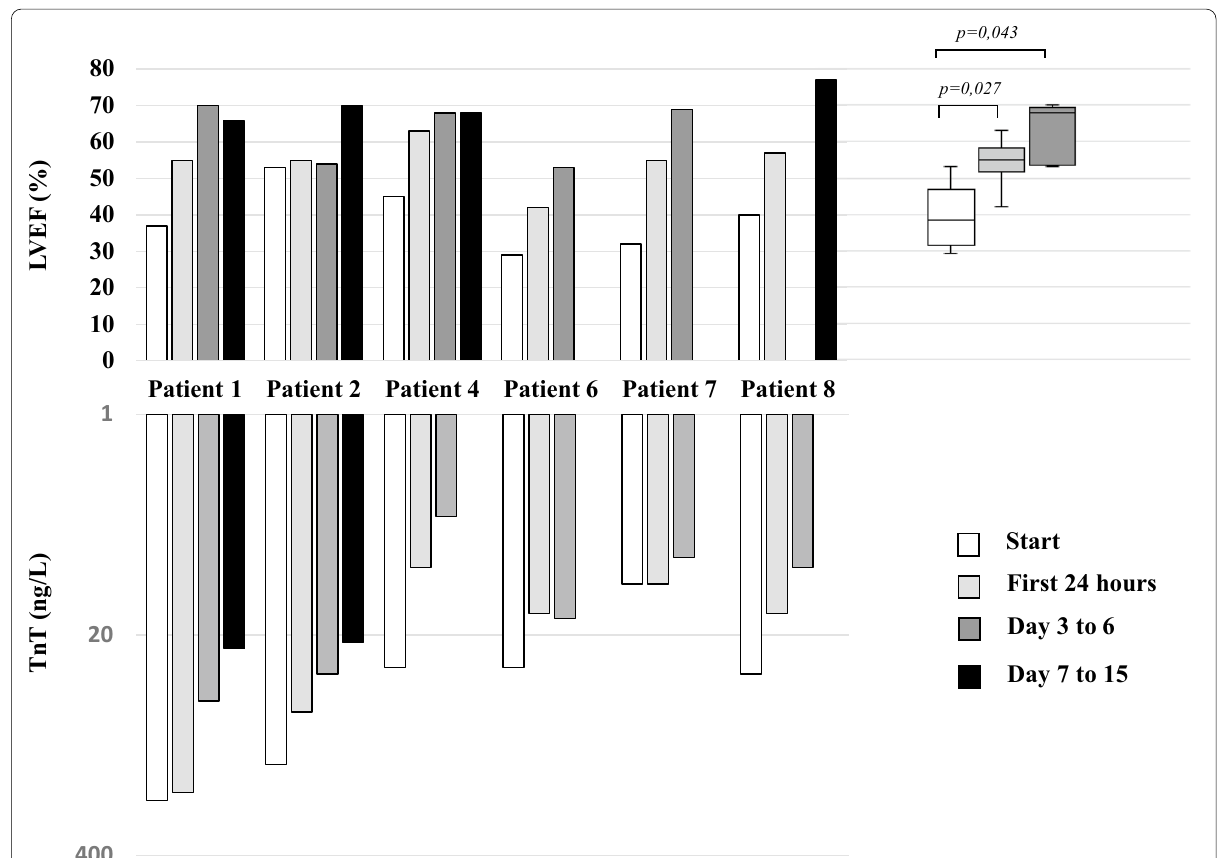
Fig. 1 Left ventricle ejection fraction and serum troponin T following anakinra therapy. Values are expressed as LVEF (%) at days 0–2, days 3–6, and days 7–15 after Anakinra therapy. Wilcoxon sign rank test was used to test paired values. LVEF, Left Ventricle Ejection Fraction; TnT, Troponin